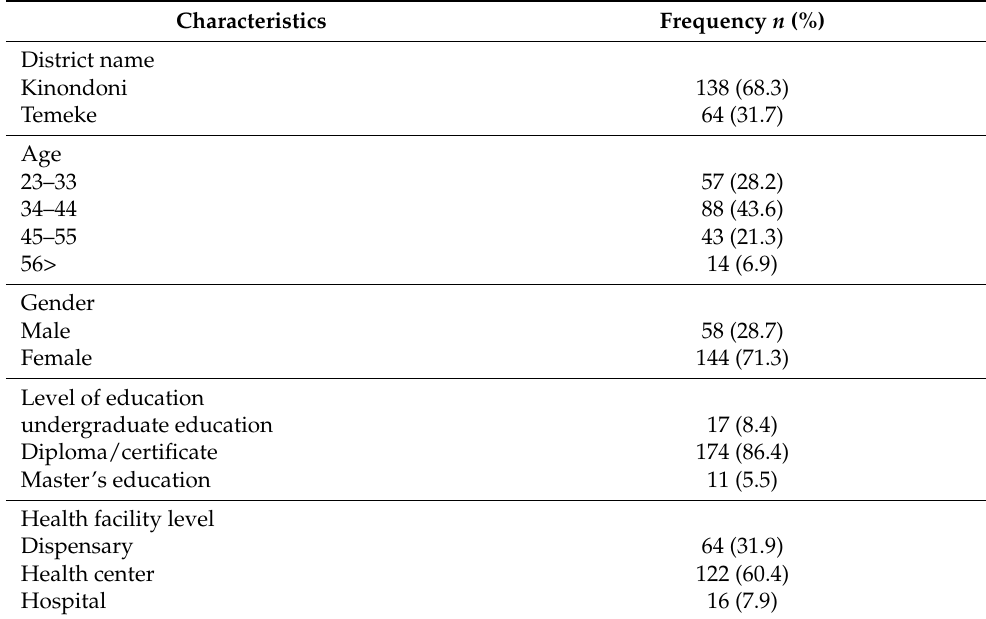
Table 1. Sociodemographic